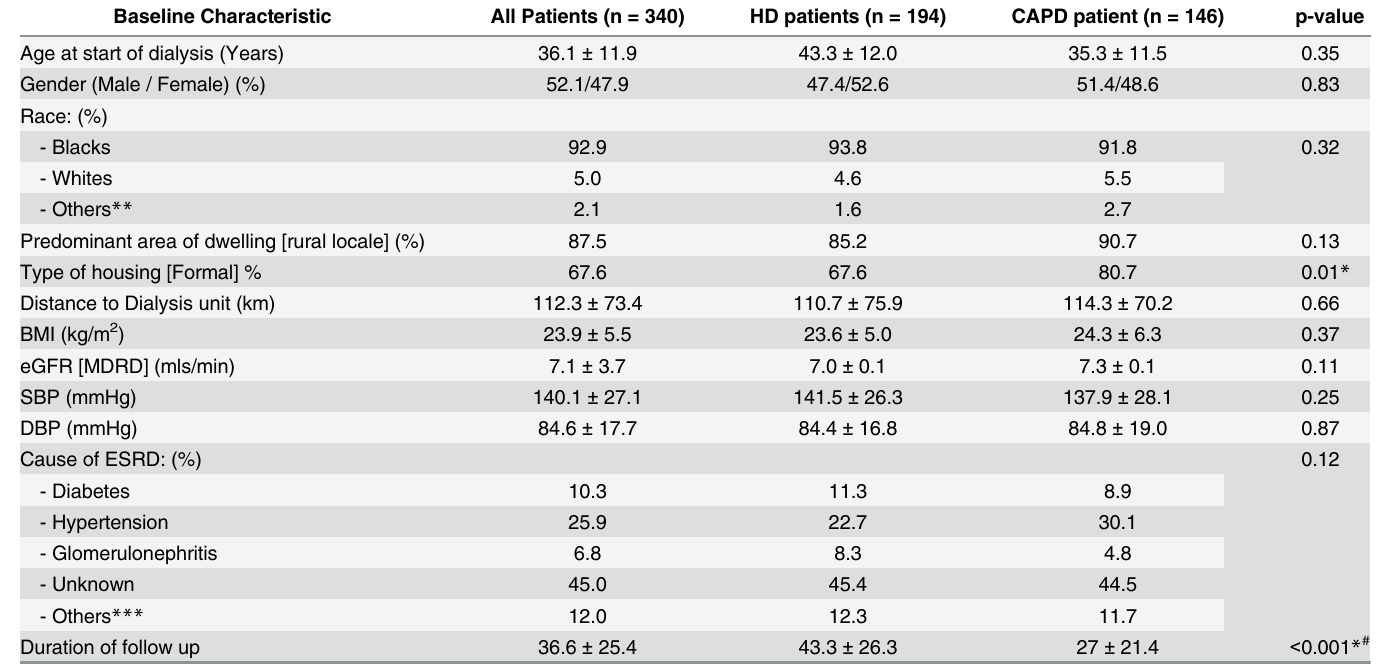
Table 1. Baseline demographic and clinical characteristics of patients according to modality. Baseline